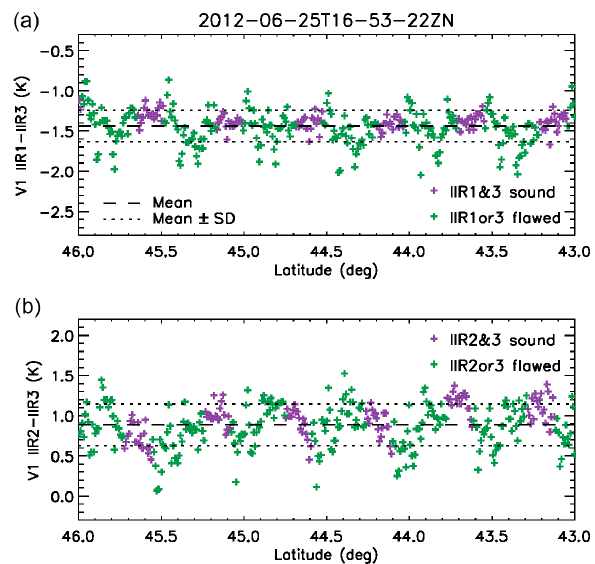
Figure 6. Version 1 IIR1-IIR3 (a) and IIR2-IIR3 (b) inter-channel BTDs along the CALIOP track for the same cloud-free scene over water surface on 25 June 2012 as in Fig. 3. Purple: sound rows in both channels; green: flawed rows in at least one channel. The hor- izontal lines show the mean value (dashed) and mean value ± stan- dard deviation